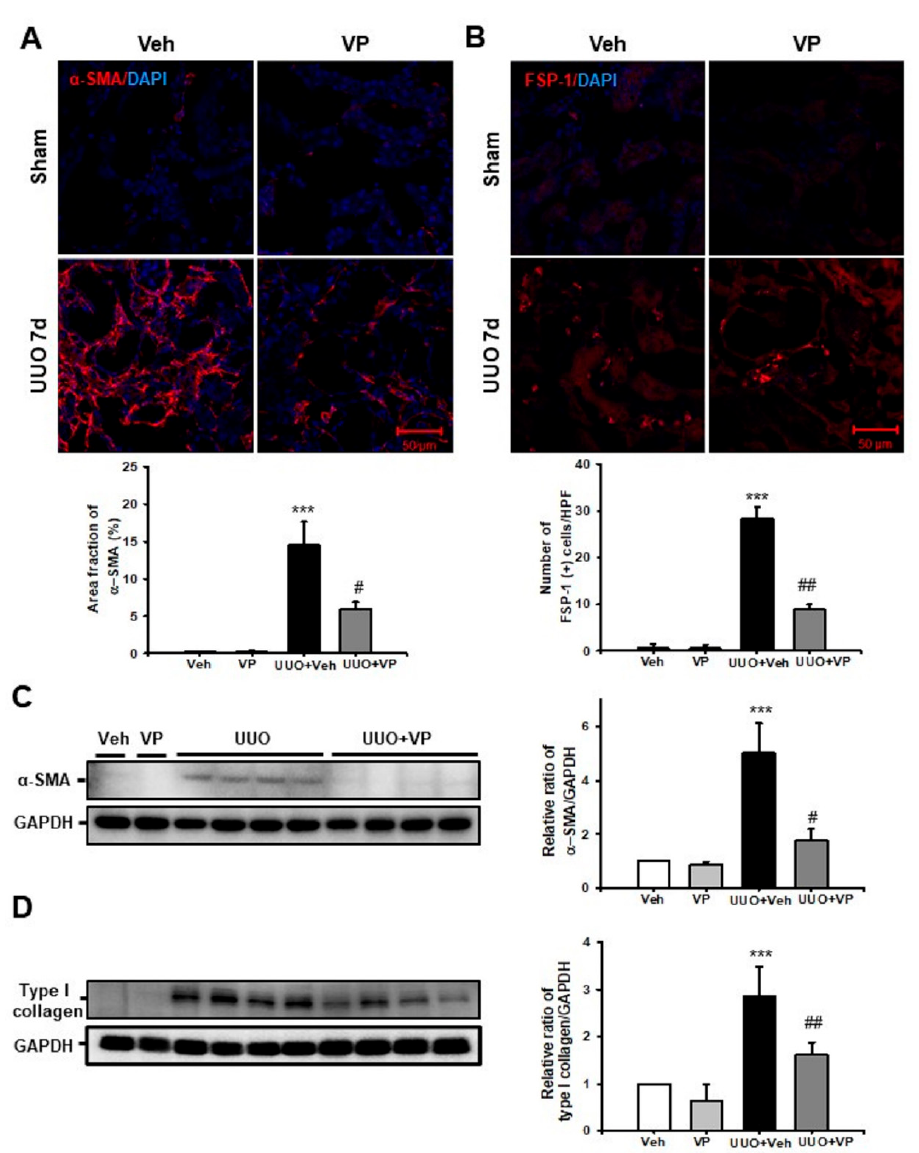
Figure 2. Effect of verteporfin on UUO-induced renal fibroblast activation. Representative immunofluorescence staining of α -SMA ( A ) and FPS-1 ( B ) from the kidneys of sham- and UUO-operated mice treated with vehicle (Veh) or verteporfin (VP). The nuclei were stained with DAPI. The bar graph shows the number of α -SMA and FPS-1 positive cells from ten randomly chosen, non-overlapping fields ( n = 10) at a magnification of x400 ( n = 15/group). Scale bar = 50 µm. Data are expressed as the mean ± SD. *** p < 0.001 versus Veh or VP; # p < 0.05, ## p < 0.01 versus UUO. α -SMA ( C ) and Type I collagen ( D ) expression in kidney tissue from sham and UUO-operated mice treated with Veh or VP was evaluated by Western blotting. Data from the densitometric analysis are presented as the relative ratio of each protein to GAPDH. The relative ratio measured in the kidneys from sham-operated mice treated with Veh is arbitrarily presented as 1. Data are expressed as the mean ± SD. # p < 0.05 versus UUO. Veh, vehicle; VP, verteporfin; UUO, unilateral ureteral obstruction operated mice; α -SMA, α -smooth muscle actin; FSP-1; fibroblast-specific protein-1; DAPI, 4’,6-diamidino-2-phenylindole; GAPDH, glyceraldehyde 3-phosphate